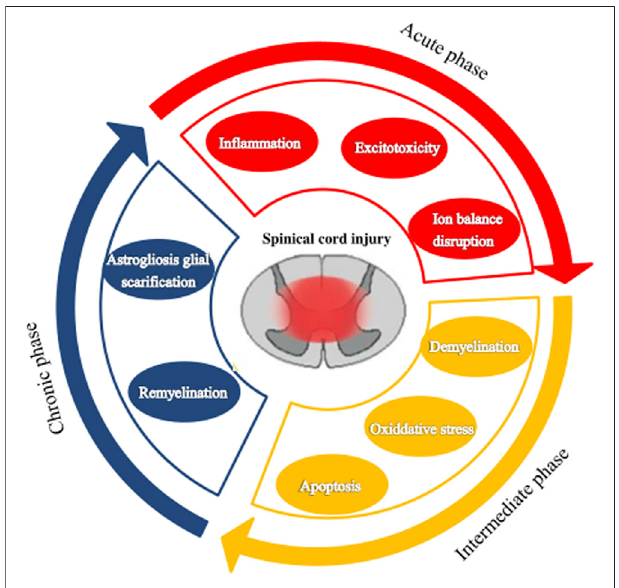
FIGURE 1 | The pathophysiological processes following spinal cord injury. Spinal cord injury can be divided into three stages: acute, subacute (or moderate), and